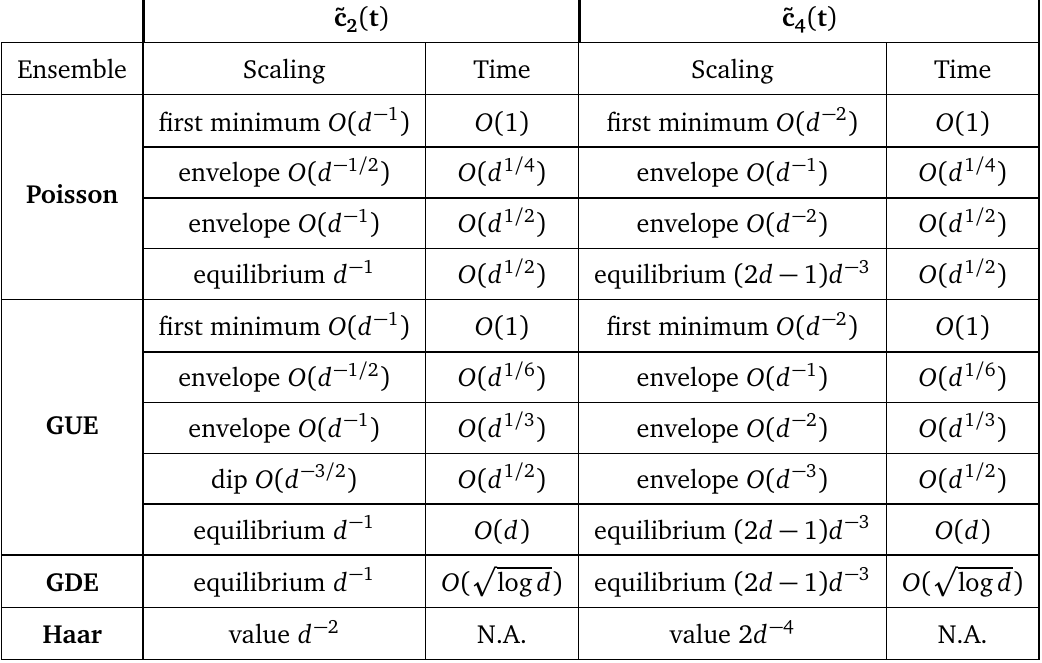
( t ) E ( Left ) and ˜ c ( t ) E ( Right ) obtained by the Table 2: Timescales and values for ˜ c 2 4 time evolution U = exp ( − iHt ) for the ensembles of Hamiltonian: Poisson, GUE, GDE, while the last one is U drawn from the Haar measure. The reported scaling values can be explicitly computed from the envelope curves of the spectral average ( t ) for a = 2,4. The details of the calculations for these quantities are presented of ˜ c a in Sec. 4. ( t ) ˜c ( t ˜c 2 4